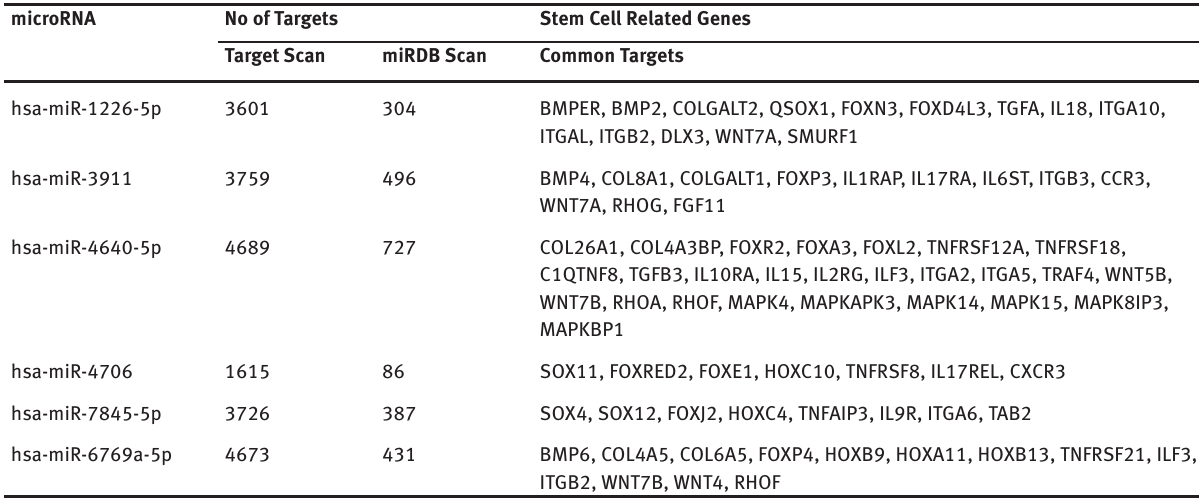
Table 2: Target genes of differentially expressed miRNA in response to SDF-1 treatment in human BMSCs.